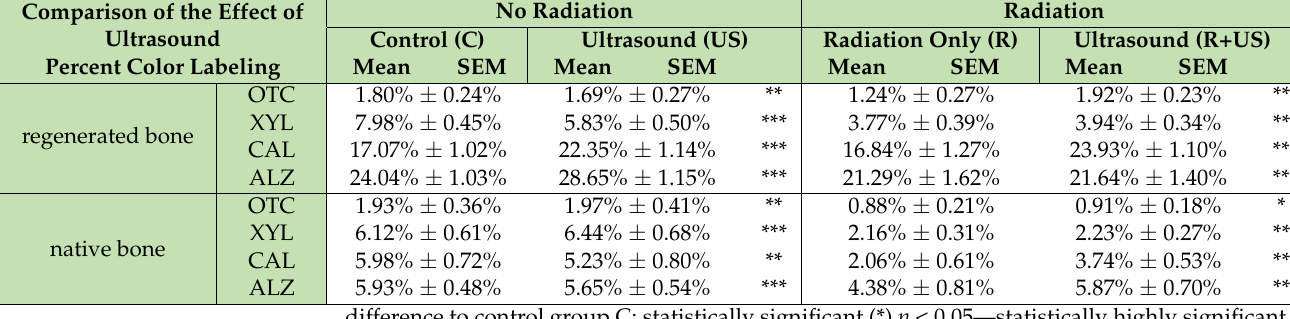
23.93% of CAL integration were clear signs of active bone growth in the regenerated area from woven to lamellar bone were observed. At this point in the healing process, the group: 5.98% and US group: 5.23%) compared to those in the native irradiated tibial bones, which were 50% less (R group: 2.06% and R+US group: 3.74%). The final label, ALZ, made up the majority of the dye in the regeneration area. As indicated in Table 1, approximately 20–25% of bone growth occurs during this late stage. Table 1. Percentage of fluorescence color Table 1. Percentage of fluorescence color labeling.